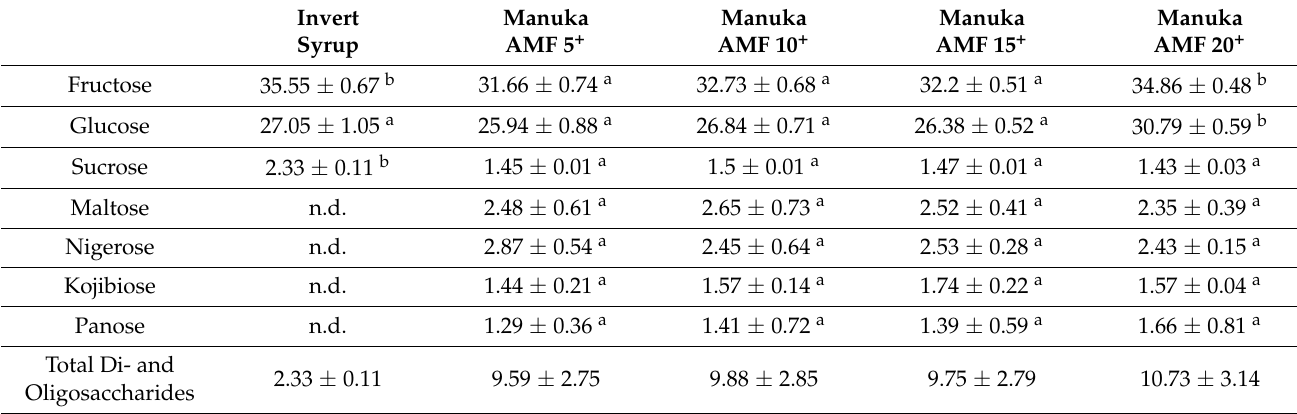
Table 1. Concentrations (% w/w ) of mono-, di- and oligo-saccharides (mean ± standard error of mean) in Manuka honey and invert